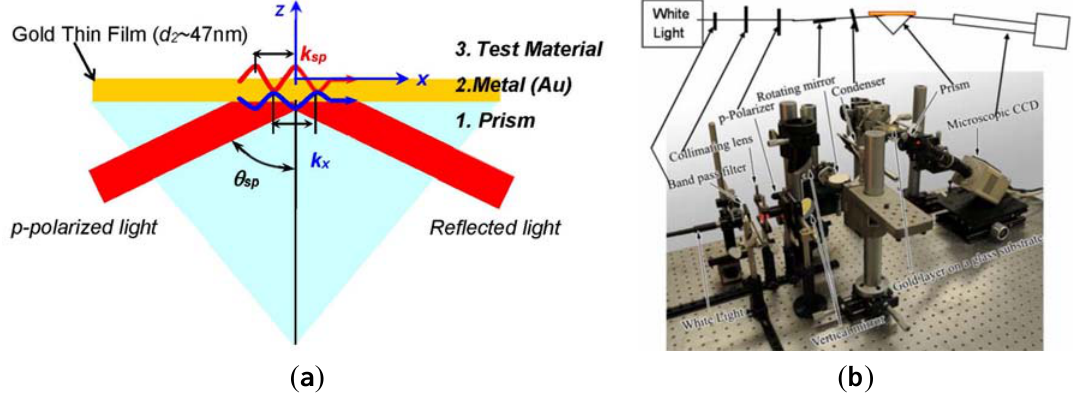
Figure 1. Surface plasmon resonance (SPR) system: ( a ) Kreschmann configuration of a three-layered SPR principle, where the glass prism, the metallic gold film and the test medium are labeled 1, 2, and 3, respectively, and ( b ) the experimental layout of the SPR imaging system using a p -polarized white light source [5]. Reprinted with permission from [6]. Copyright 2015 Elsevier Science Direct.